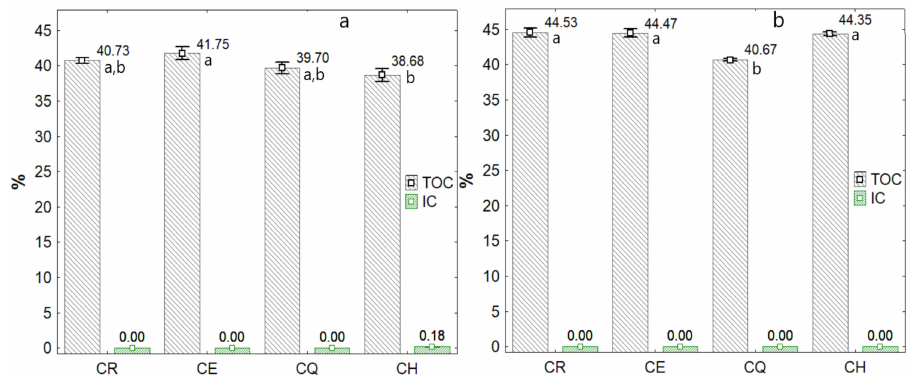
Figure 2. Total carbon in the nostoc, ( a ) dehydrated and ( b ) spray-dried. Different letters indicate significant difference, evaluated with the Tukey test at 5%